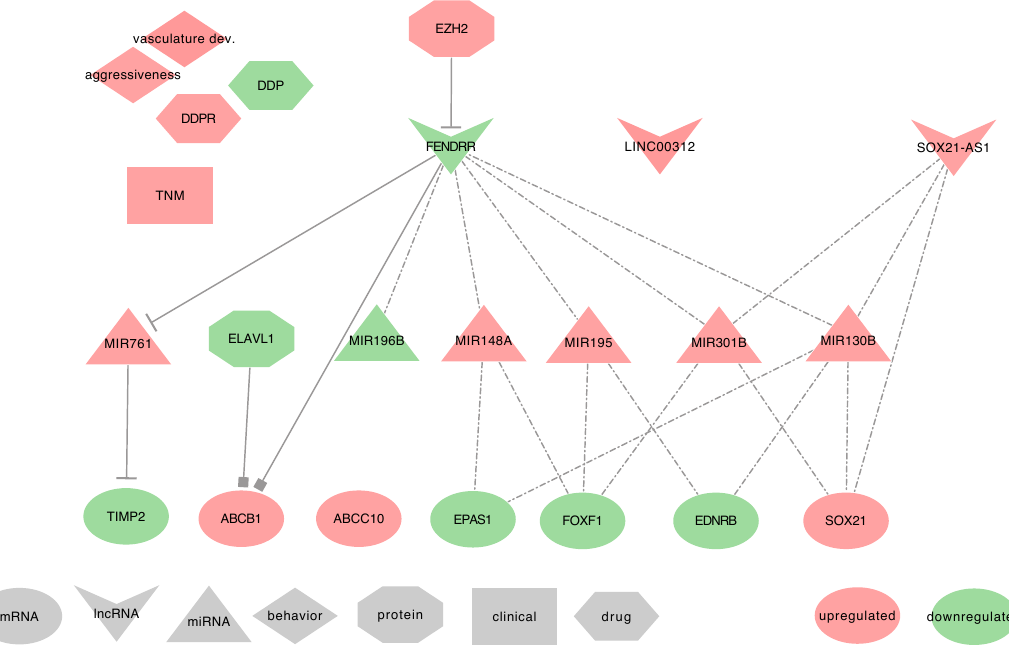
Figure 8. FENDRR in lung cancers: A network of lncRNA-miRNA-Protein interactions. Upregulated molecules are in green. Downregulated molecules are in red. Shape definitions are in grey. Gray arrows target the activated molecules. T-ended lines target the inhibited molecules. Square-ended lines represent a binding between molecules. Dashed-dot lines represent an association with unknown